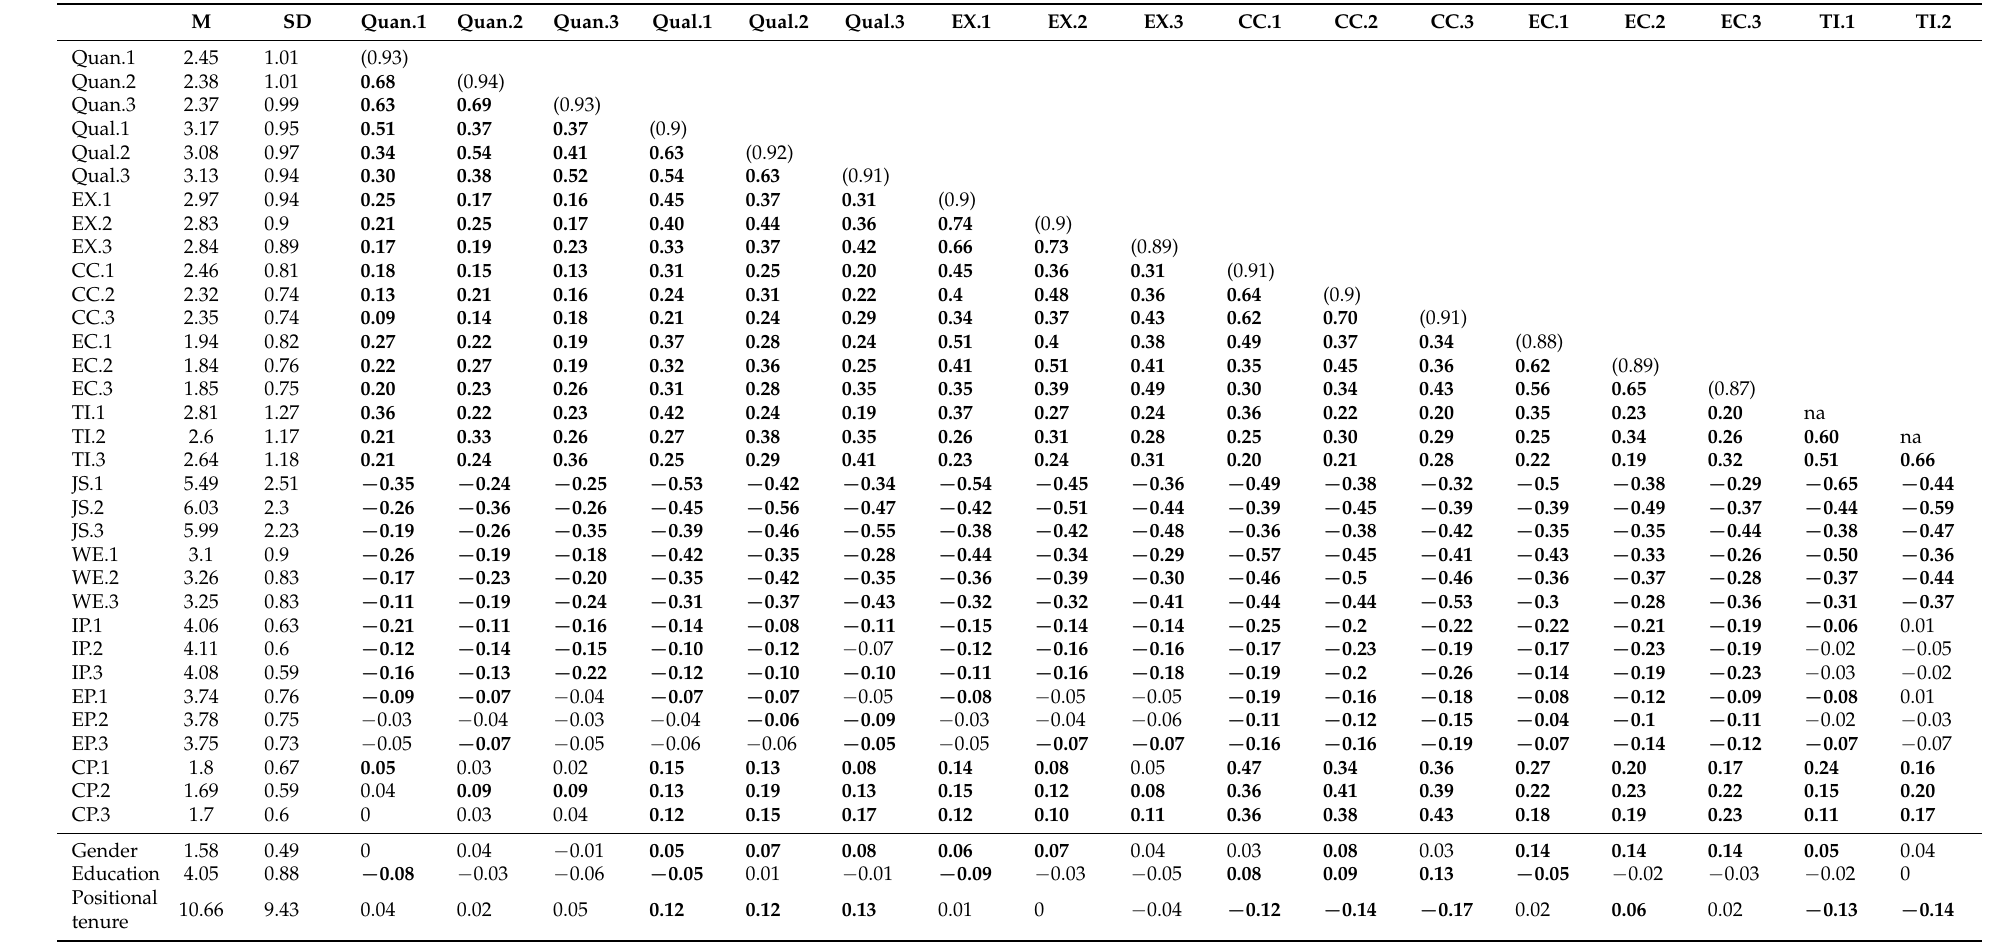
Table 1. Means, standard deviations, reliabilities (Cronbach’s alpha in parentheses), and